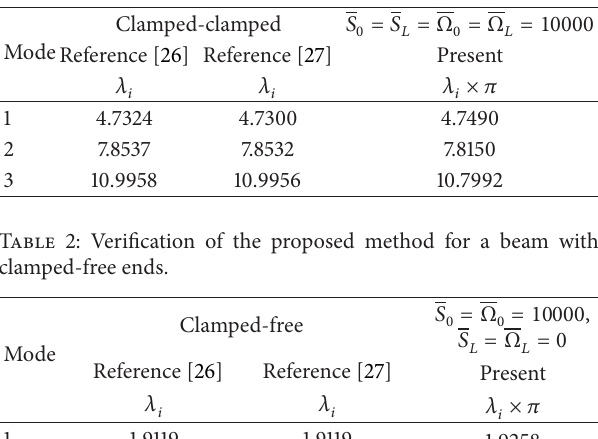
Table 1: Verification of the proposed method for a beam with clamped-clamped ends.